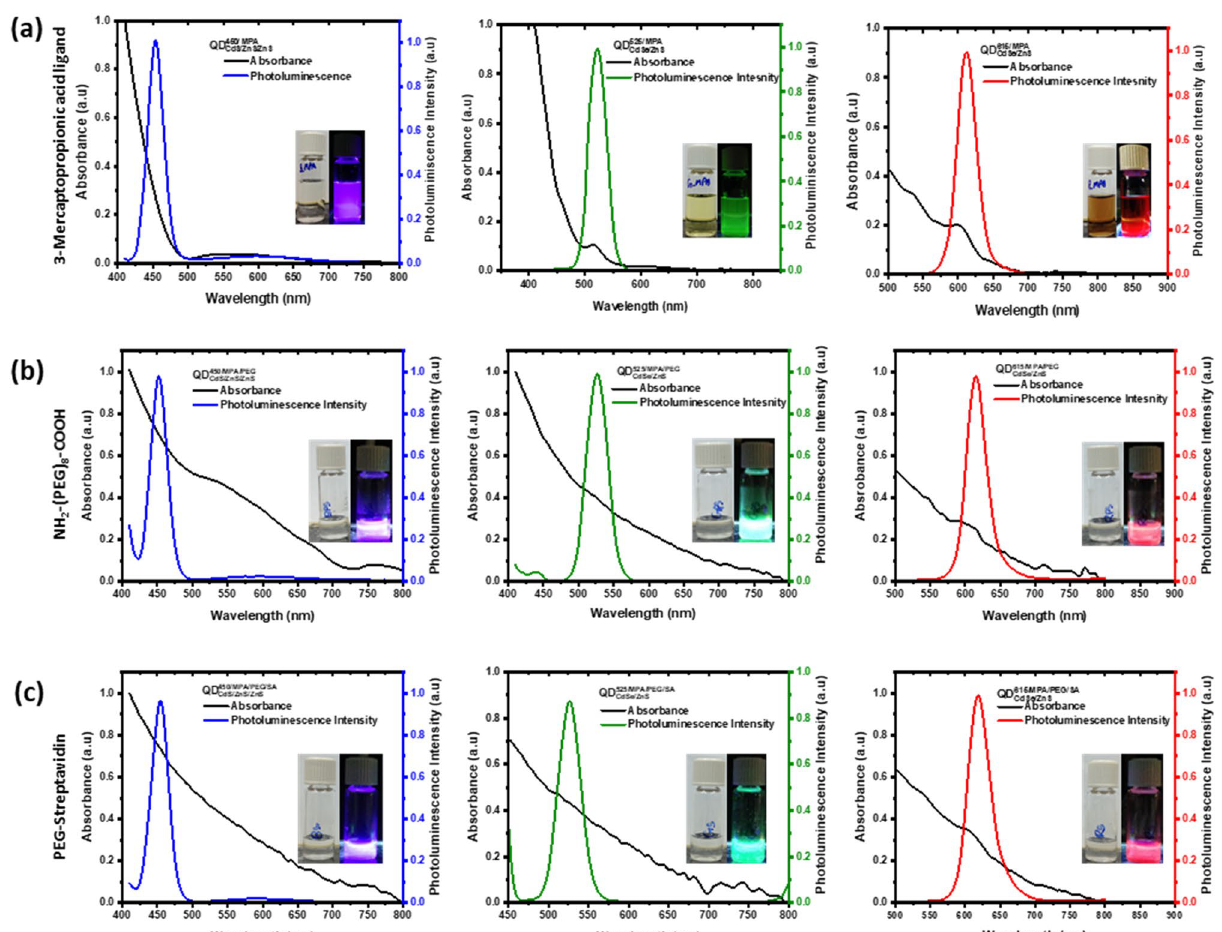
450 / MPA QD 525 / MPA CdS / ZnS , CdSe / ZnS , QD 450 / MPA / PEG CdS / ZnS , QD 450 / MPA / PEG / SA CdS / ZnS ,